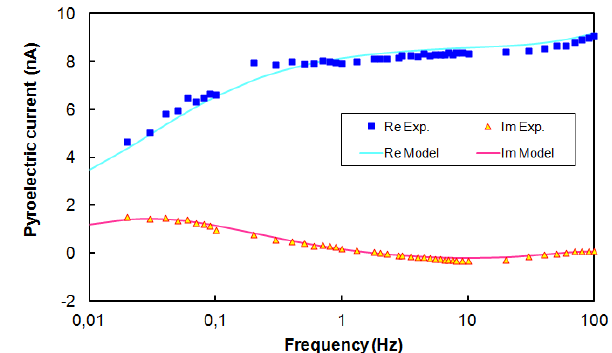
Figure 3. Pyroelectric current spectrum of a MFC actuator in com- parison to a fit to Eq. (5).